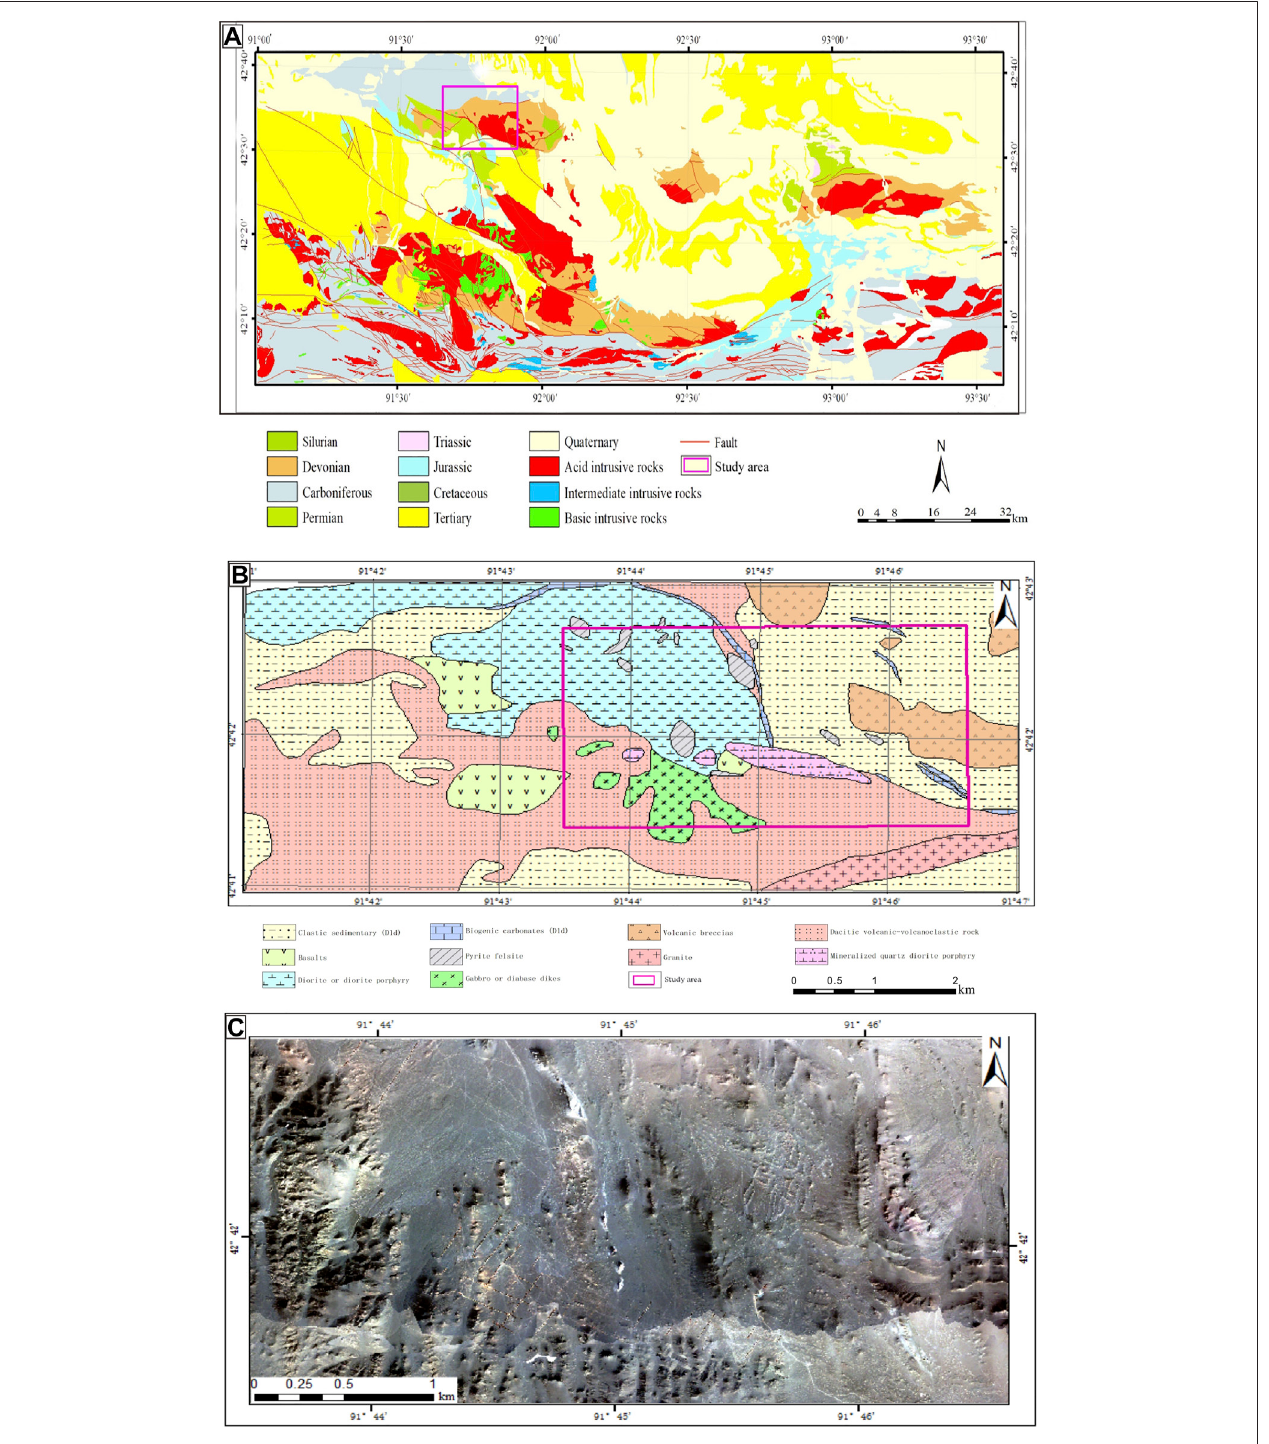
FIGURE 1 | Schematic diagram of study area (A) Overview map of Kalatag district; (B) generalized geological map of Yudai; (C) hyperspectral images from the HySpex airborne fl ight.